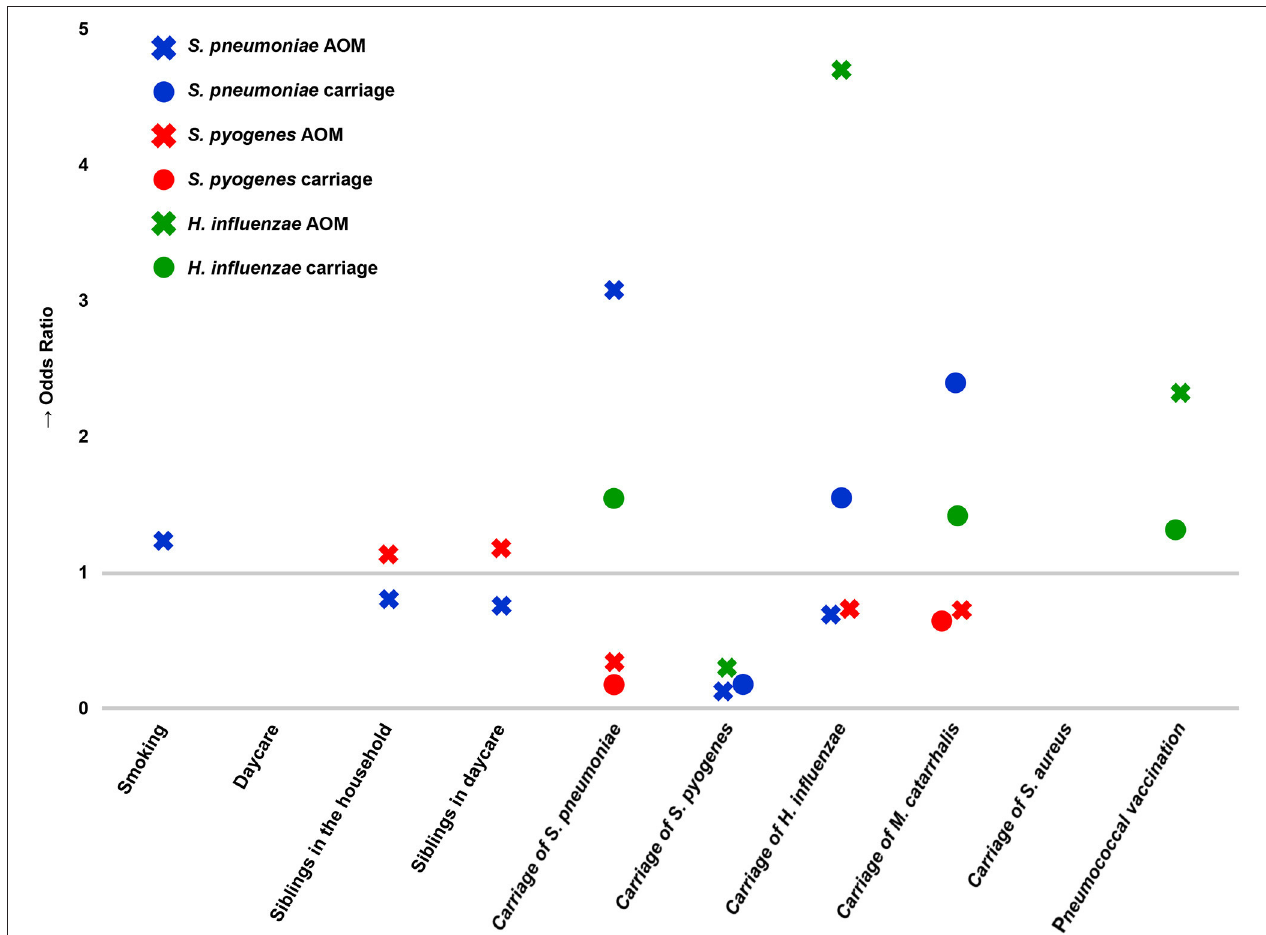
FIGURE 8 | Associations of acute otitis media (crosses) and nasopharyngeal carriage (circles) with interspecies carriage and demographic factors. Associations with an odds ratio < 1 indicate decreased occurrence of an event; odds ratios > 1 indicate increased occurrence of an event. Associations were determined with univariate logistic regression, and results for which the 95% confidence interval of the odds ratio did not cross 1 are